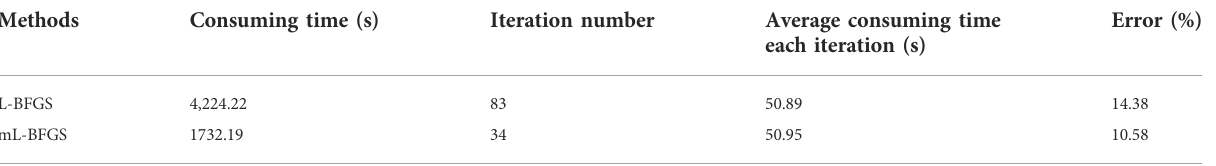
TABLE 2 Comparison between L-BFGS and mL-BFGS in FWI with noise-added